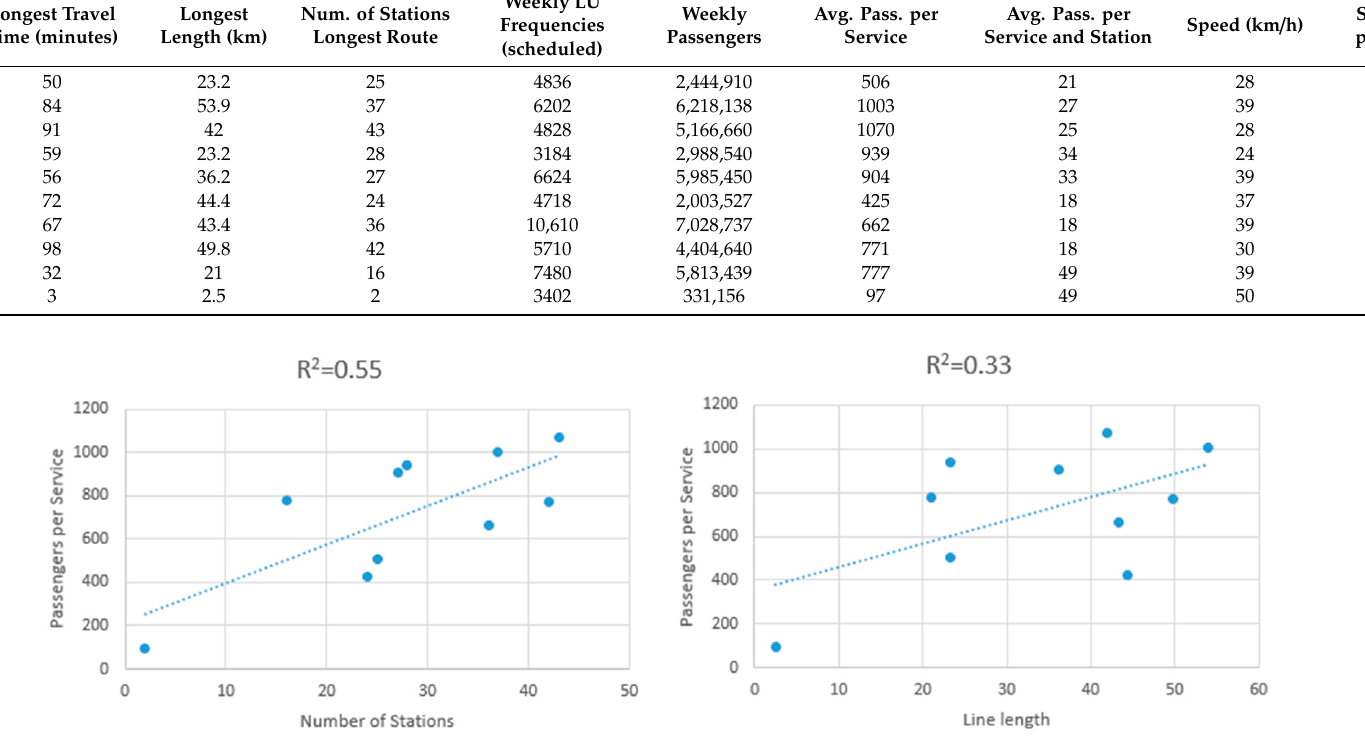
Figure 9. Linear regression of passengers per service versus line stations ( left ) and line length ( right ).